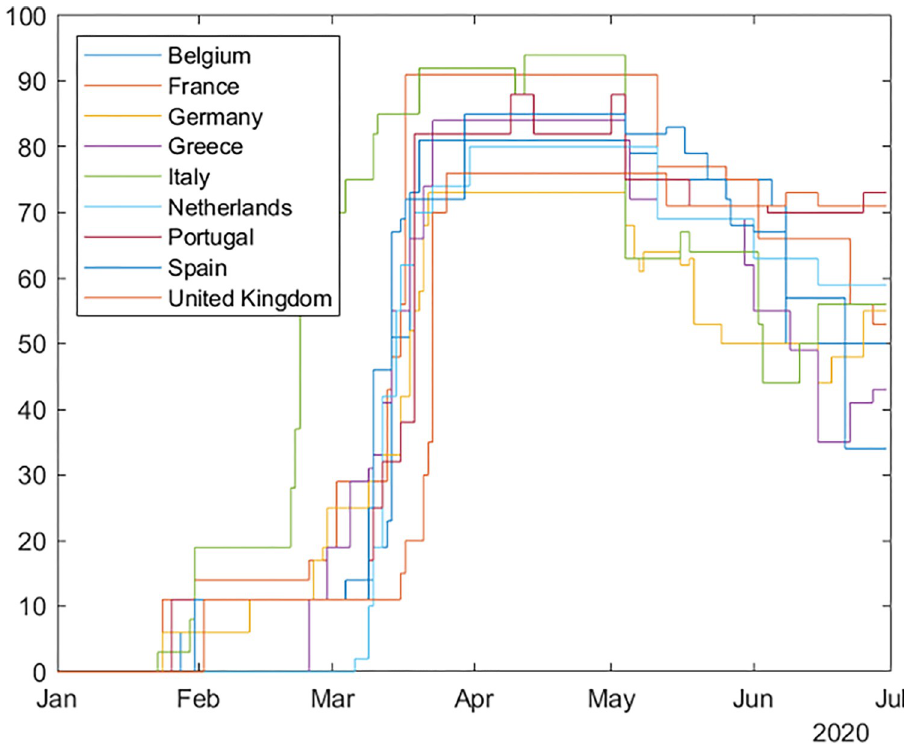
Fig 2. Oxford Stringency Index. Evolution of the Oxford Stringency Index in selected European